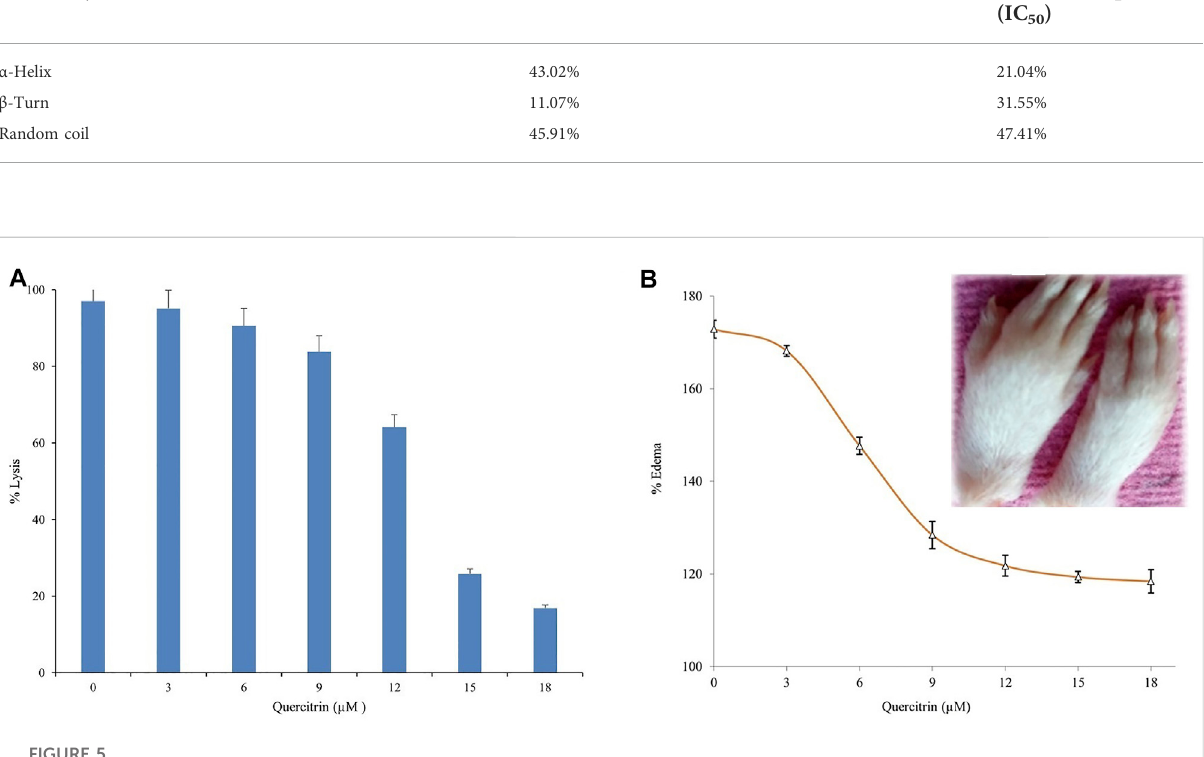
FIGURE 5 Neutralization of sPLA 2 IIa induced indirect hemolytic activity and edema. (A) Quercitrin in the range of 0 – 18 μ M concentration neutralized sPLA 2 IIa induced indirect hemolytic activity in a dose-dependent manner. (B) Quercitrin (0 – 18 µM) neutralized the edema-inducing activity of